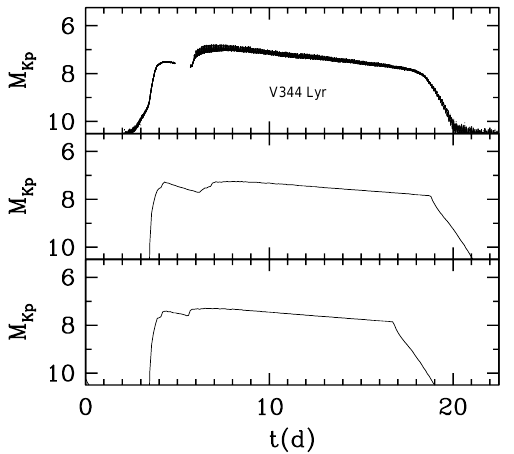
Figure 1: A comparison of Kepler data on V344 Cyg with two SOs in a long light curve using the pDI